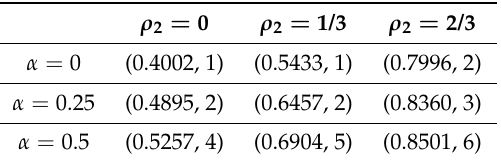
Table 3. Effect of the level of good will shown by decision-maker (DM)1 on the efficiency and equilibrium length of the short list in games where r = σ 1 = σ 2 = 1 and ρ 1 = 0 (the first value in each cell gives the efficiency and the second the empirically derived equilibrium length of the short list). As the level of good will shown by DM1 increases, he gives DM2 a greater number of options to choose from. Also, when the preferences of the DMs are independent, the intensity of search by the DMs (i.e., the longest short list) is greatest when the correlation between the signals observed in the two rounds is high. In this case, close observation of a number of offers is very likely to lead to the selection of an offer which is attractive to both